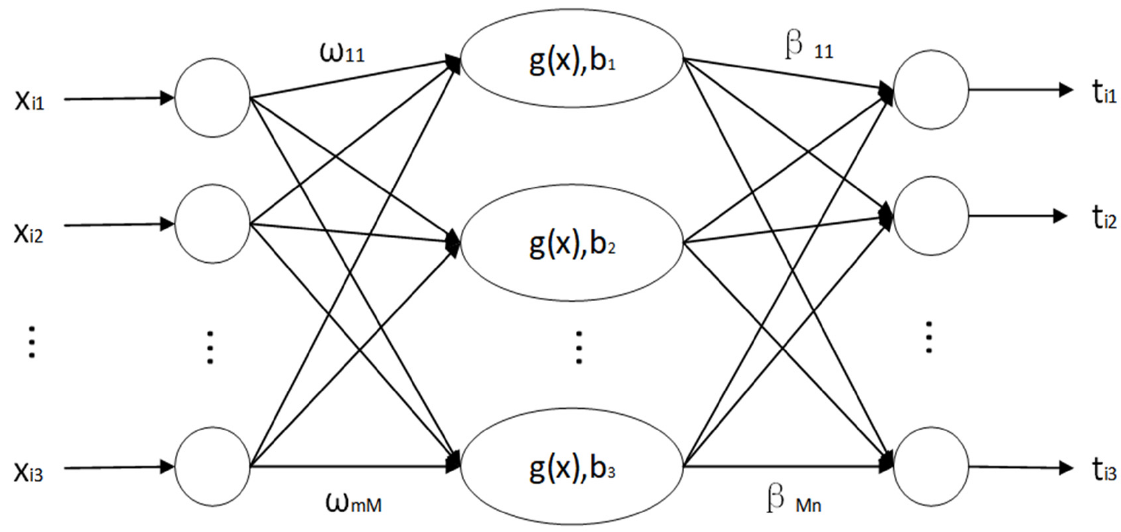
Figure 1. Schematic of extreme learning machine network training model.